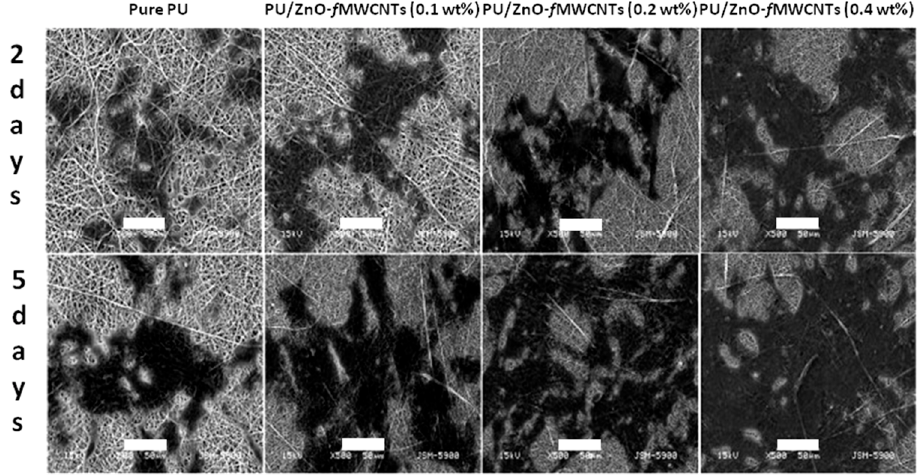
Figure 16. SEM micrographs showing adhesion and proliferation of MC3T3-E1 pre-osteoblasts on different nanofibrous scaffolds for two and five days. Scale bar is 50 μ m. Modified with permission from reference [107]. Copyright (2017) Elsevier.